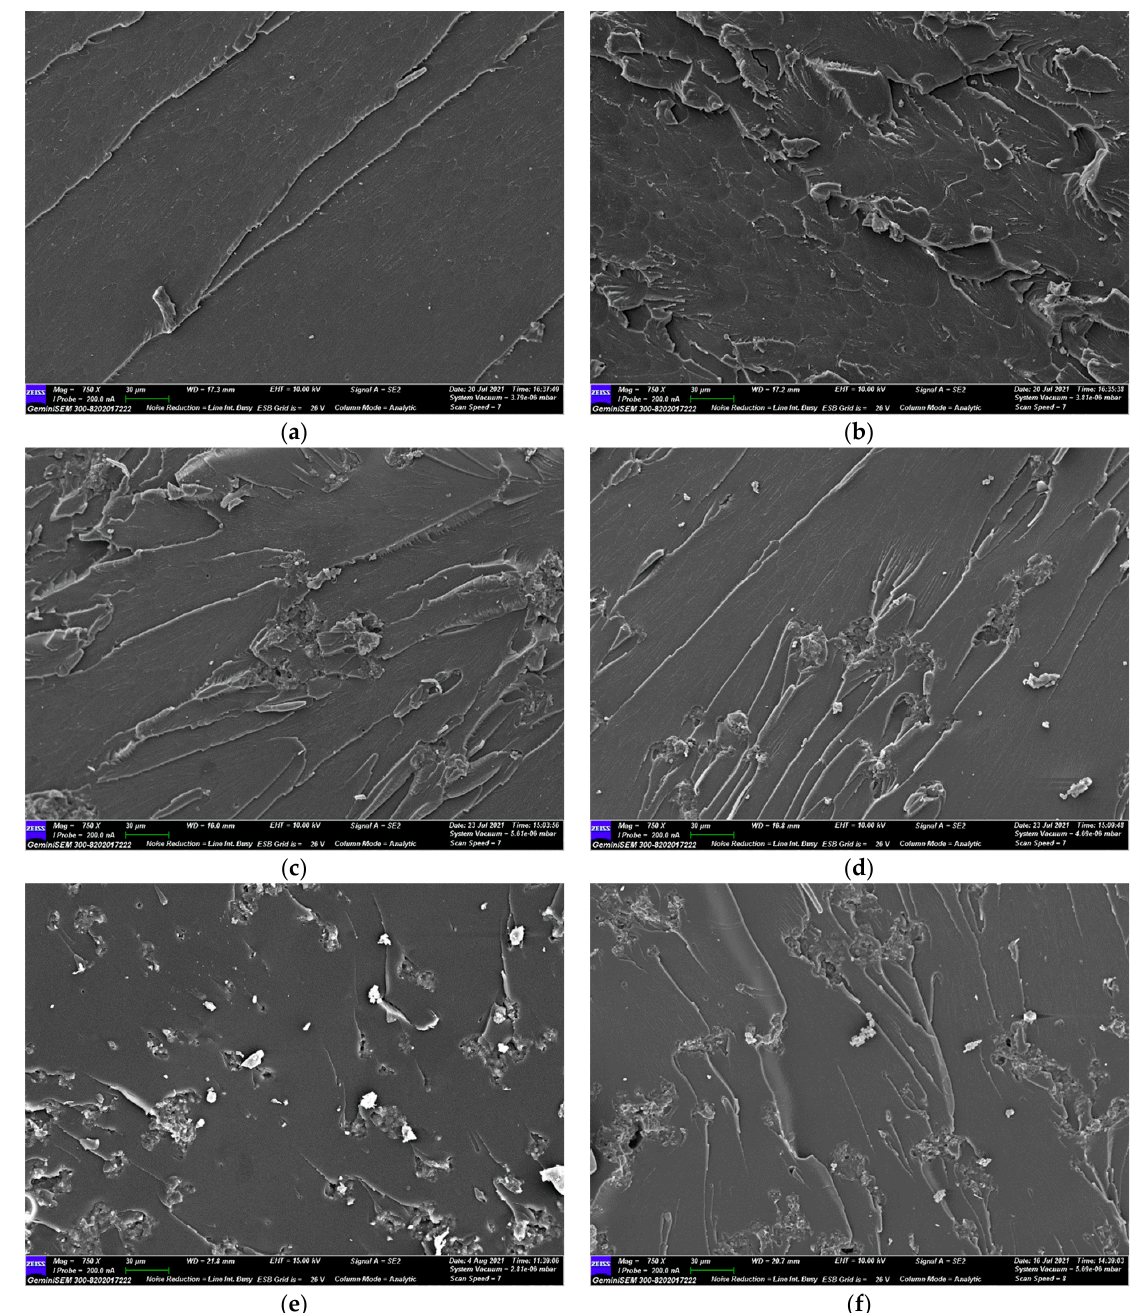
Figure 8. Scanning electron microscopy of E0. ( a ) 0.1 and ( b ) 0.01 mm/s, EC-10 ( c ) 0.1 and ( d ) 0.01 mm/s, EC-30 ( e ) 0.1 and ( f ) 0.01 mm/s.